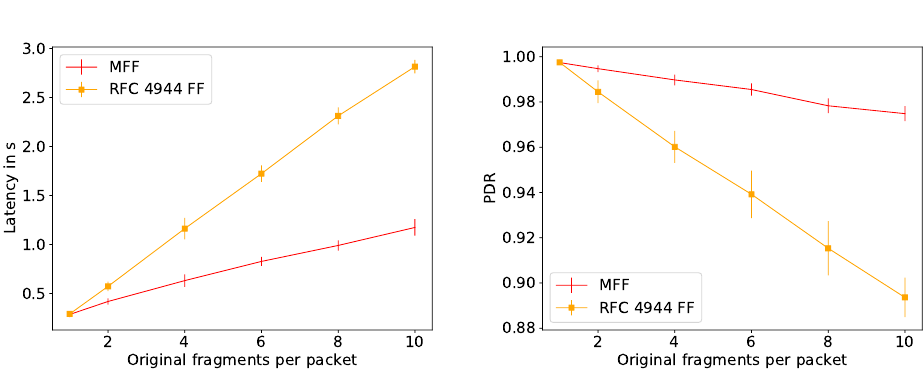
Figure 6. Bottleneck topology.